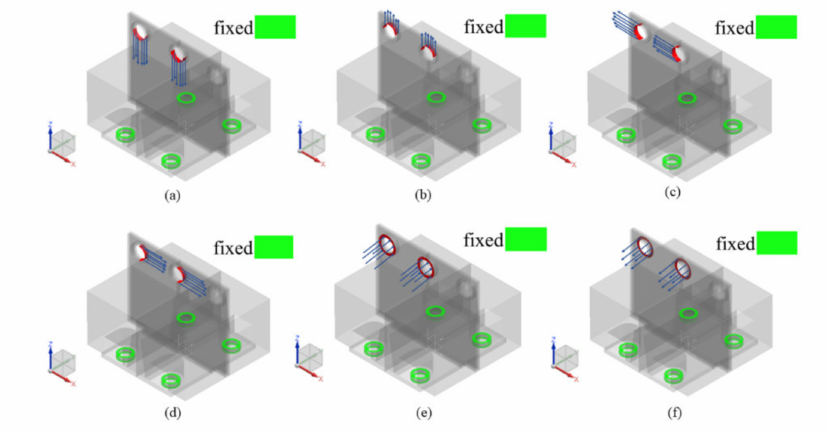
Figure 6. Six kinds of loads in condition 1. The green regions are fixed boundary conditions. The red regions are the location of external loads. ( a ) represents the first load case in condition 1; ( b ) represents the second load case in condition 1; ( c ) represents the third load case in condition 1; ( d ) represents the fourth load case in condition 1; ( e ) represents the fifth load case in condition 1; ( f ) represents the sixth load case in condition